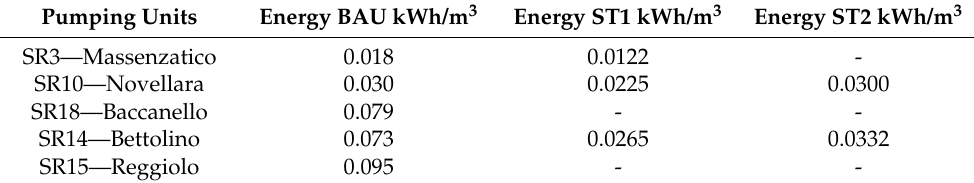
Table 9. Energy contribution from pumping units upstream SRs for BAU and alternatives strategies. Pumping